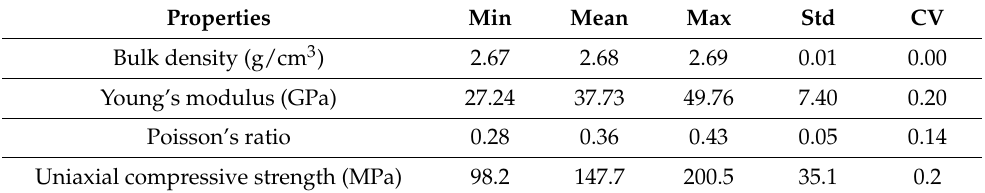
Figure 5. Volumetric strain and stiffness curves (sample No. 2) with respect to the stress level in the increment of 0.2 MPa/s. The degree of damage for granite was calculated by normalizing the crack volumetric strain after crack initiation stress level ( σ ci ). Table 1. Descriptive statistics of 10 granite specimens collected from